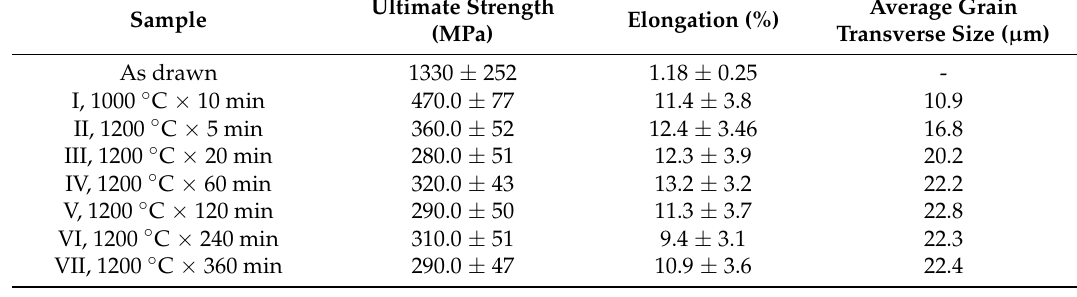
Table 3. Tensile properties of single fibers and average transverse size of fiber grains.